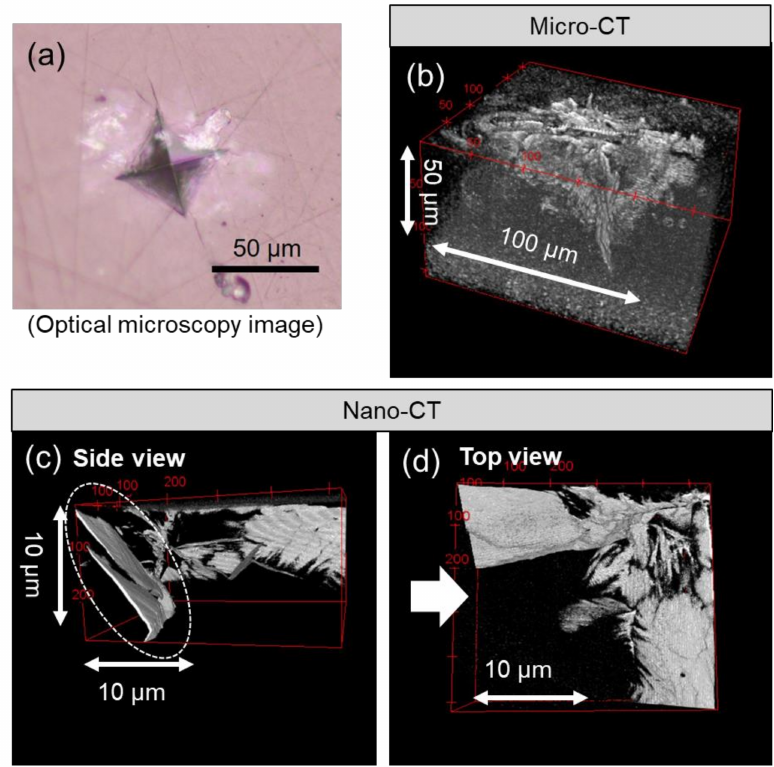
Figure 6. Microcracks observed using X-ray computed tomography. ( a ): optical microscopy image, ( b ): X-ray CT image (micromode), ( c ): Side view of X-ray CT image (nanomode) from white arrow in image (d), ( d ): Top view of X-ray CT image (nanomode).